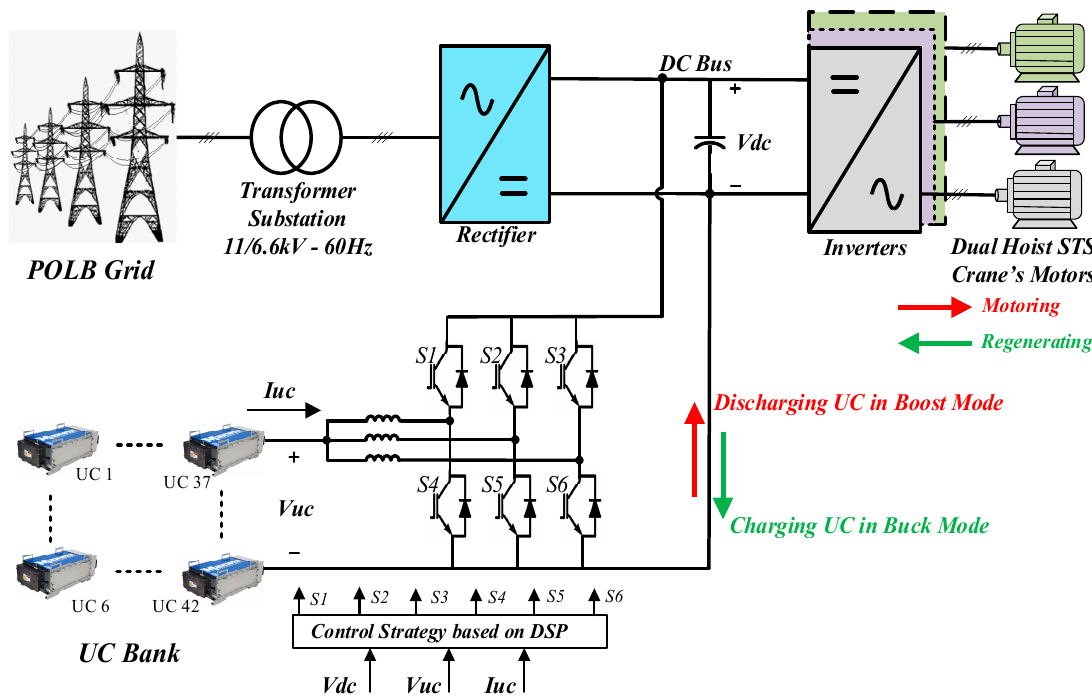
Figure 8. Ultracapacitor (UC) bank location in the dual hoist STS crane via the bidirectional DC/DC converter [35].